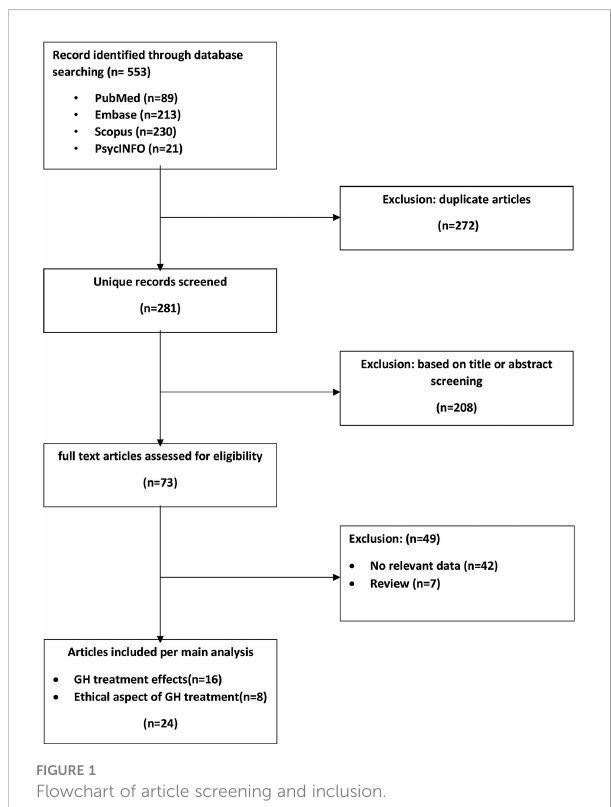
FIGURE 1 Flowchart of article screening and